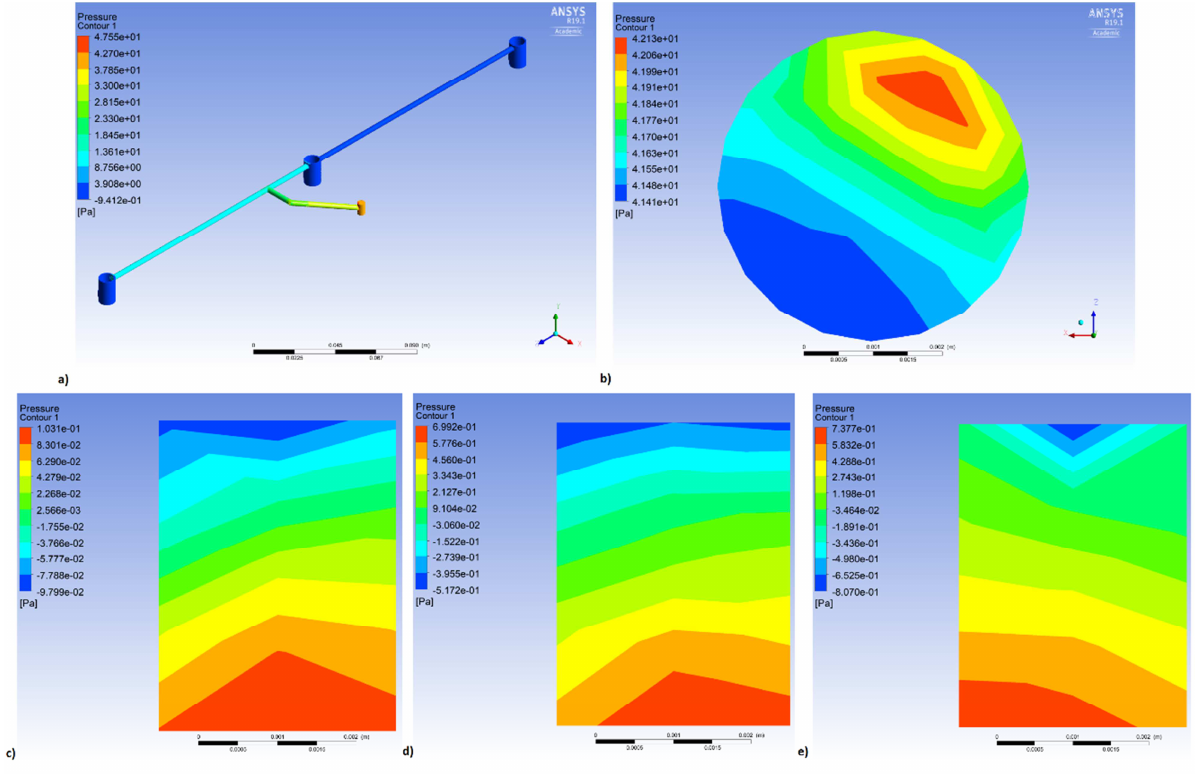
Fig. 10. Distribution of the oil pressure for the boundary condition at the inflow in the form of a constant pressure of 400 kPa, a) for the oil main line, b) at the inlet, c) at the Outlet1, d) at the Outlet2, e) at the